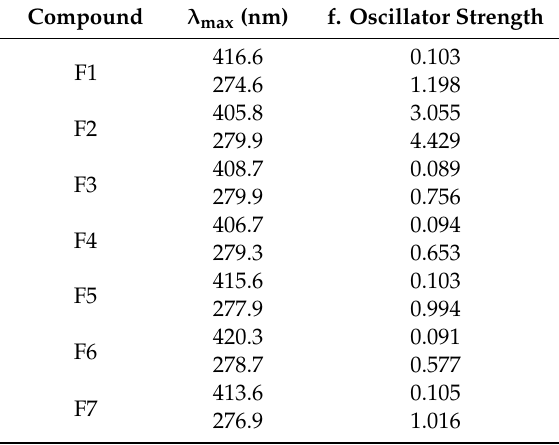
Table 3. Results of TDDFT calculations of λ max in chloroform for the new compounds.